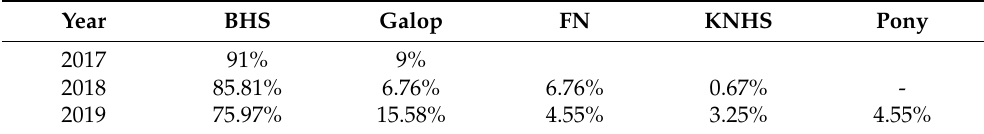
Table 5. Changes in the teaching system, data from